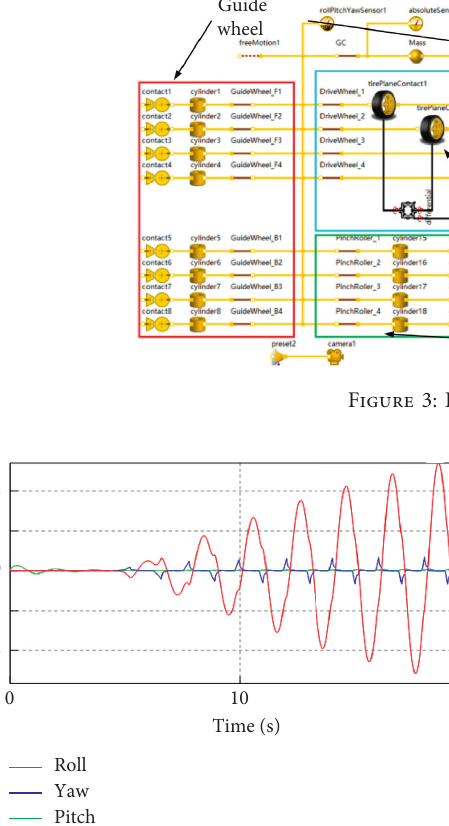
Figure 6: Change of the attitude angle of the vehicle using a single- bogie structure on bend